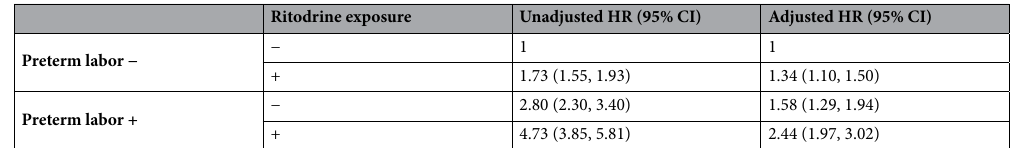
Table 4. Hazard ratios (HRs) of autism for women with and without preterm labor; subgroup analysis of autism with respect to no preterm labor without ritodrine group. Hazard ratios were adjusted for maternal age, parity, cesarean section, preterm delivery, steroid use, low birthweight, large for gestational age, male gender, and preeclampsia.